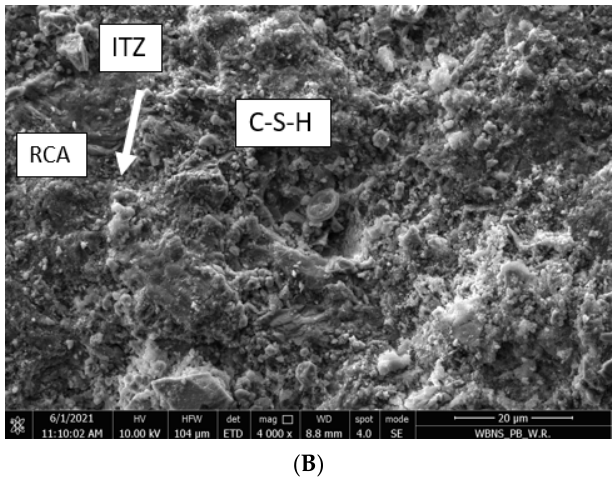
Figure 15. ( A ) SEM images for concrete reference mag. ×10,000. Interfacial transition zone (ITZ) between the NA and cement paste. ( B ) SEM images for concrete with (FAS–RCM + RCA), mag. ×4000.